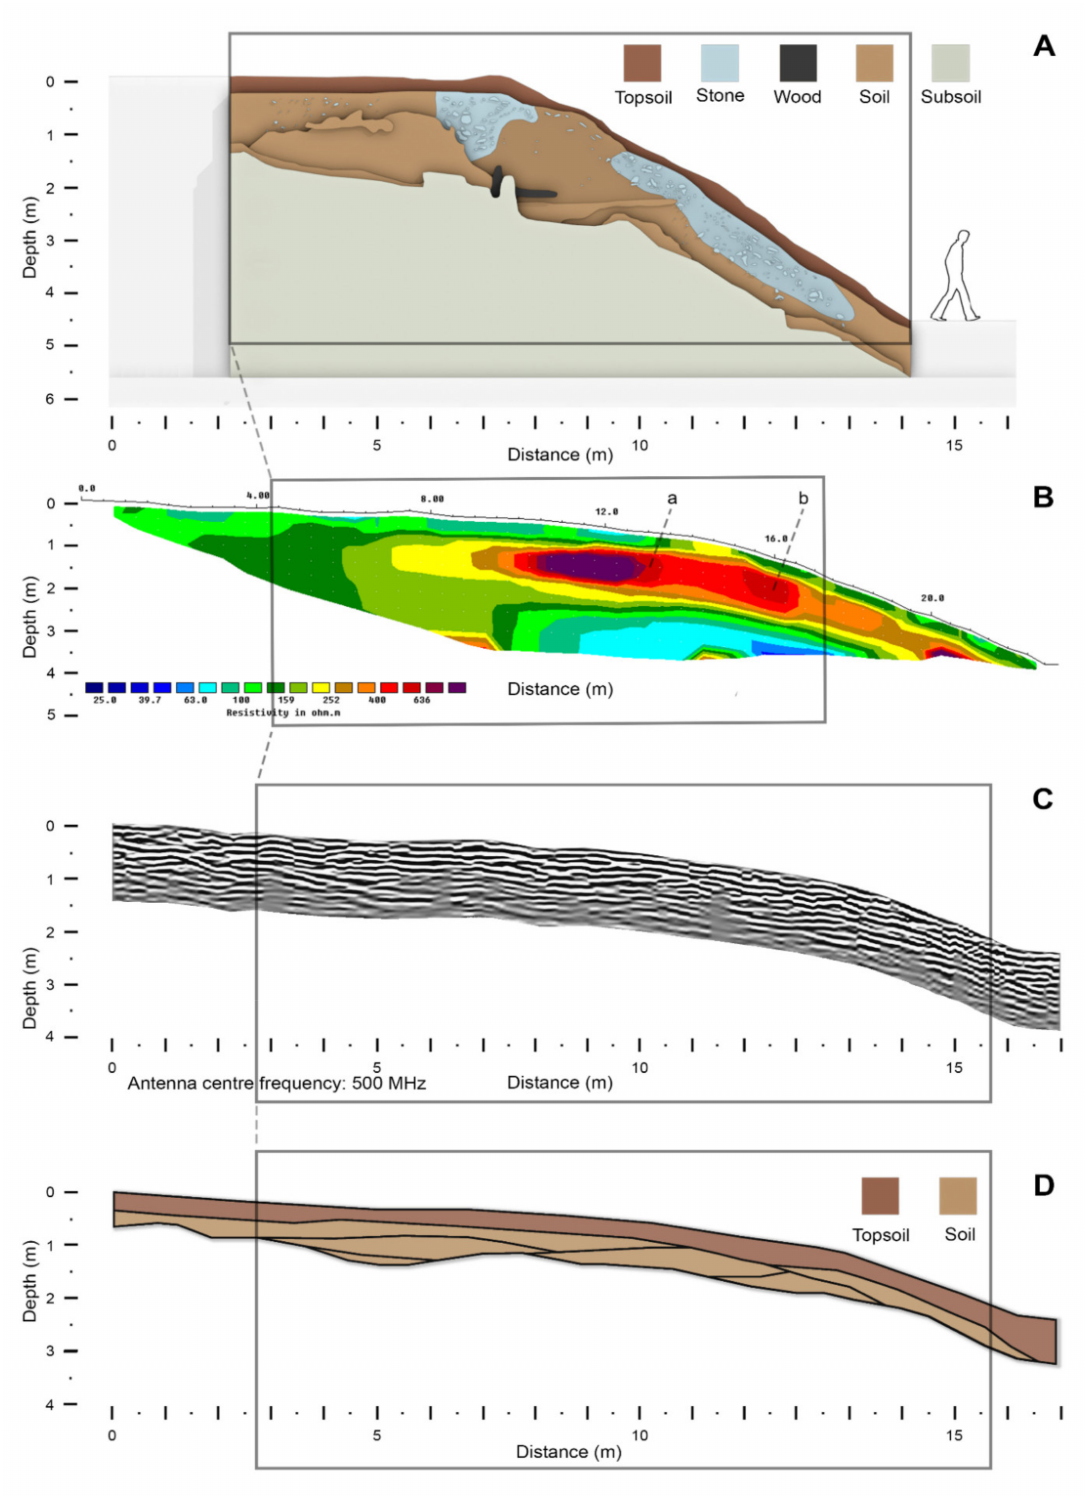
Figure 7. Brno-Star é Z á mky. ( A ): Profile of the hillfort’s fortification based on the results of ar- chaeological excavation ([9], Figure 95). ( B ): Electrical resistivity tomography model in Wenner configuration. ( C ): GPR vertical time/depth radarogram from an antenna with 500 MHz centre frequency. ( D ): Interpretation of the GPR